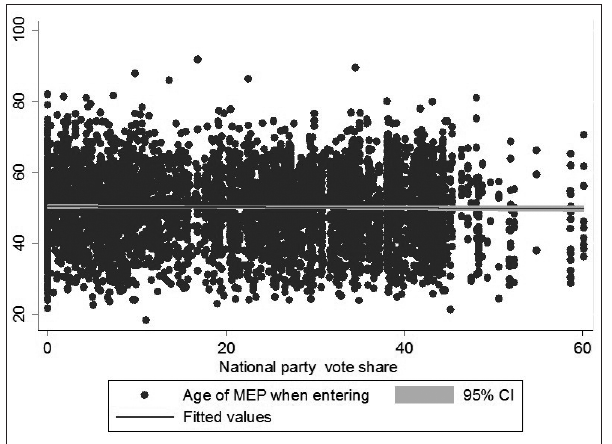
Figure 6: Scatterplot displaying the relationship between the ideology of the party (pro-European/anti-European dimension) and the age of MEPs from this